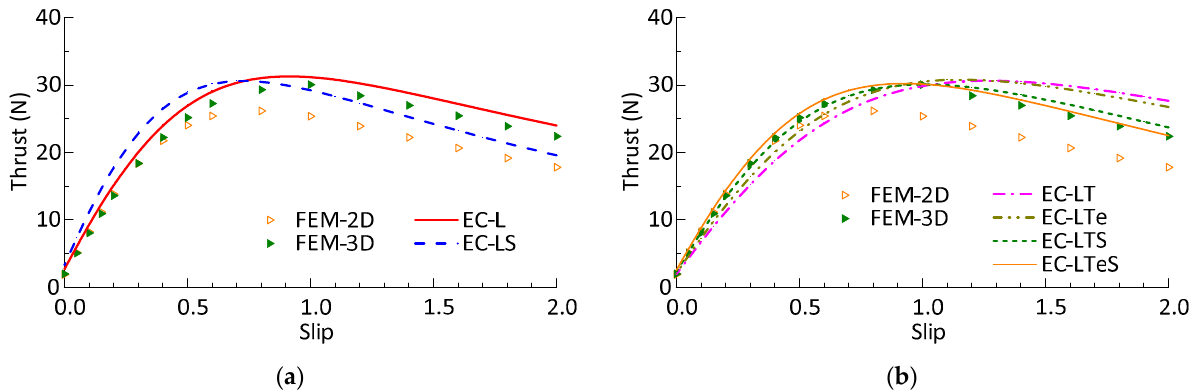
Figure 8. Thrust versus slip characteristics with a mechanical gap of 0.0105 m: ( a ) is calculated by equivalent circuit EC-L, EC-LS, FEM 2D, and FEM 3D model; ( b ) is calculated by equivalent circuit EC-LT, EC-LTe, EC-LTS, EC-LTeS, FEM 2D, and 3D model.